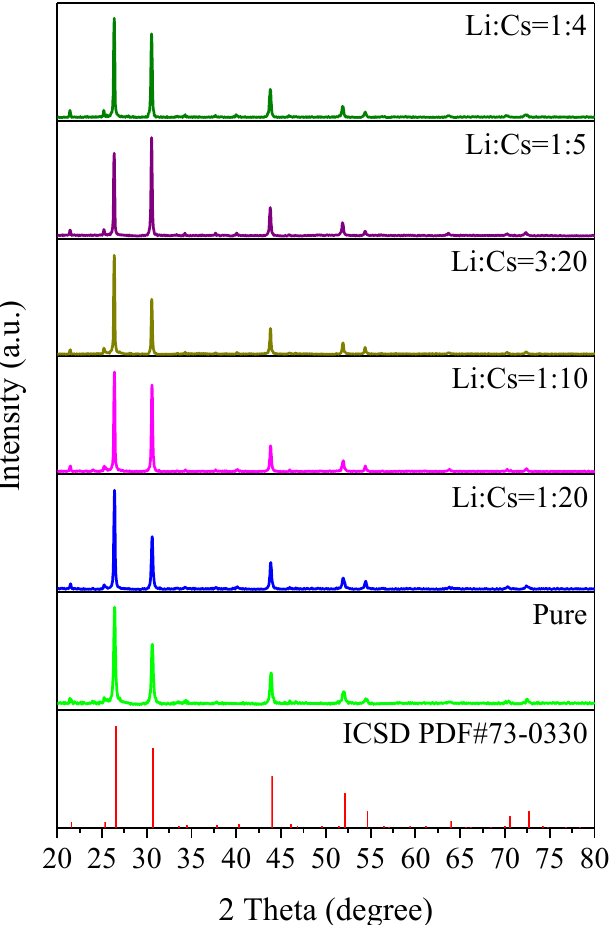
+ doped Cs 2 SnI 6 and Li 2 SnI 6 with different concentrations.